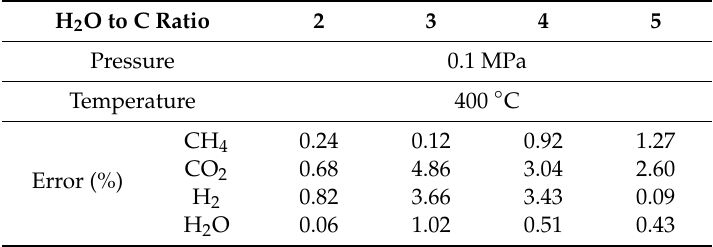
Table 3. Di ff erence analysis of experiment and calculation (%).